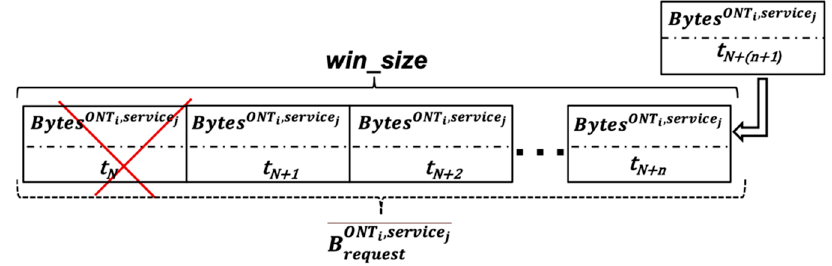
Figure 3. Operation of the sliding window implemented in the algorithm.